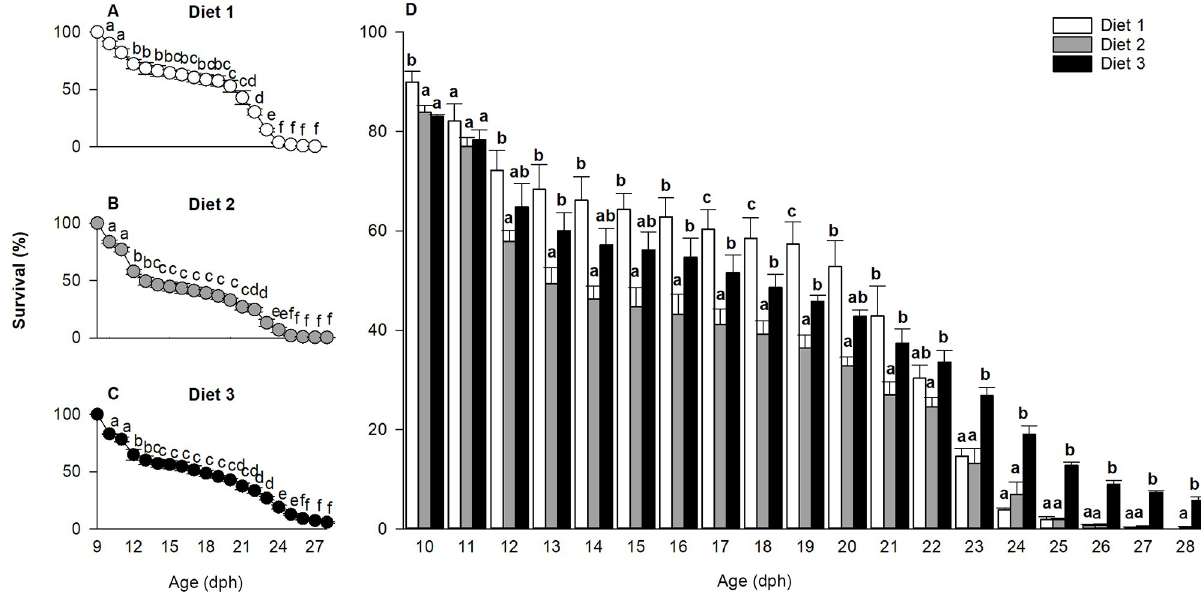
Fig 2. Effect of age for each diet (A, B, C) and effect of diets at each age (D) on European eel, Anguilla anguilla , larval survival. Values represent means ( ± SEM), while different lower-case letters represent significant differences (p < 0.05).